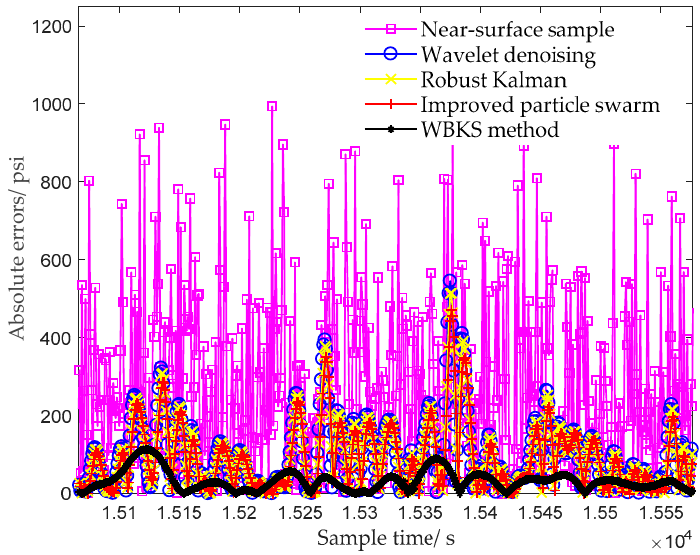
ff erent processing Figure 11. Absolute errors comparison under different processing methods. Figure 11. Absolute errors comparison under di Figure 11. Absolute errors comparison under different processing methods.